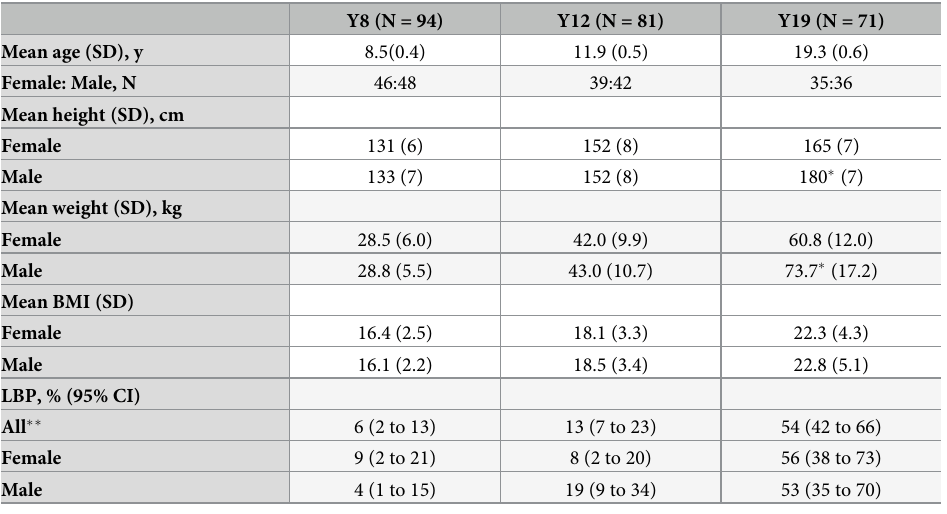
Table 1. Description of study